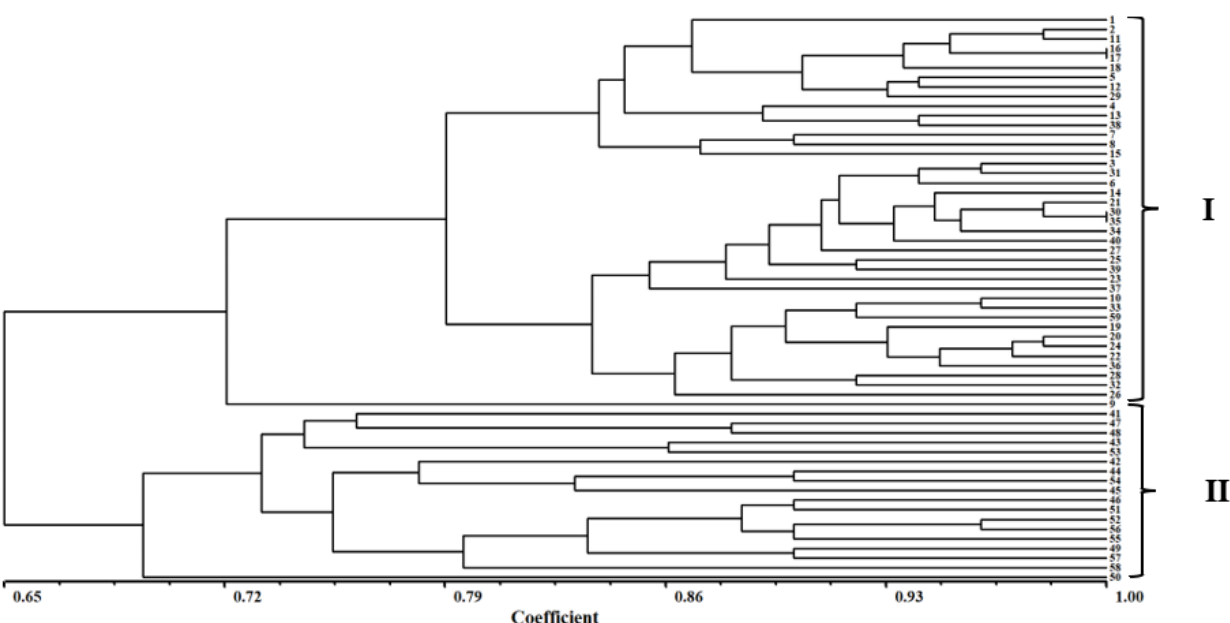
Figure 4. UPGMA analysis of 59 populations of E. indica by the Sequential Agglomerative Hierarchical and Nested Clustering (SAHN) module of the NTSYS-pc. The FIND module was used to identify all trees that could result from different choices of tied similarity or dissimilarity values.